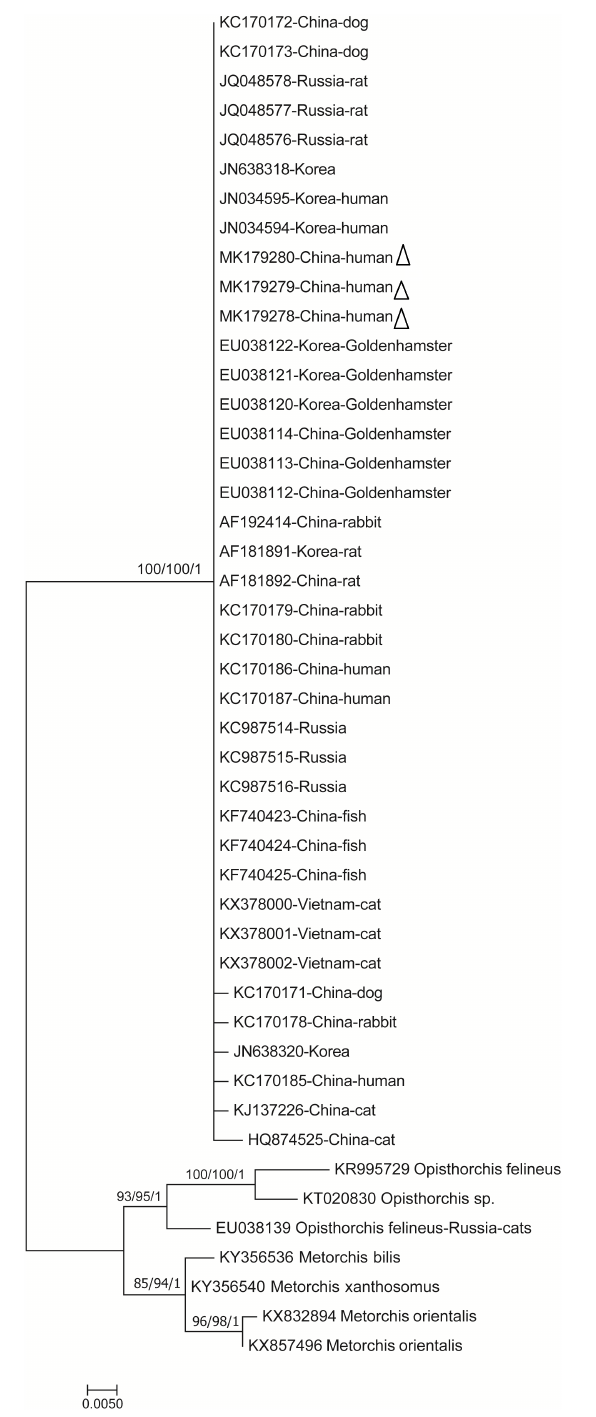
FIGURE 2 | Phylogenetic relationships between the C. sinensis isolates based on the partial ITS1 rDNA sequences. Nodal support of > 50% is shown for maximum likelihood/neighbor-joining/Bayesian Inference analyses (as indicated). Opisthorchis felineus and Metorchis bilis et al. were used for comparison. Each sequence is identified by its accession number and host origin. Genotypes with black triangle are genotypes identified in this study,